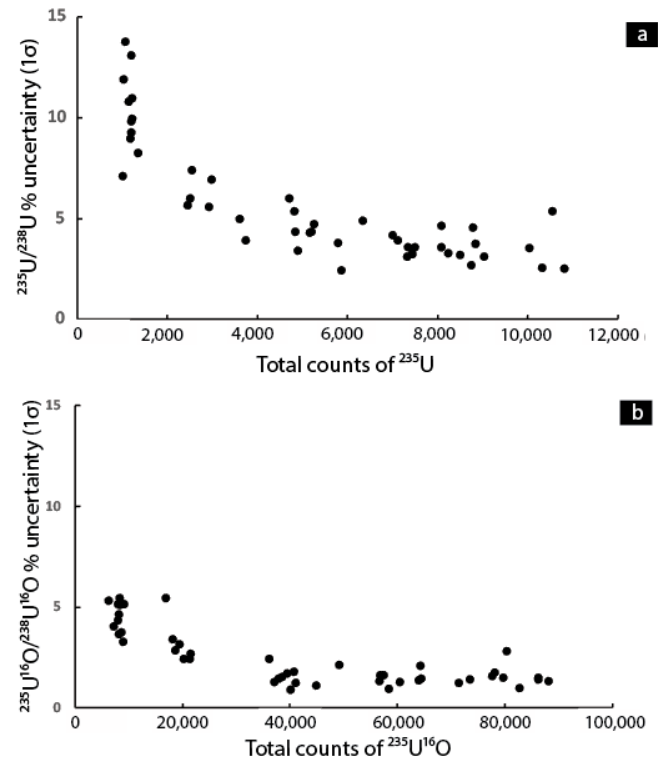
Figure 2. Plot of the percent uncertainty, calculated as 1 σ associated with the average of the ratios observed at each cycle of data during each analysis, on the ( a ) 235 U / 238 U and ( b ) 235 U 16 O / 238 U 16 O ratios as a function of the total number of counts of ( a ) 235 U and ( b ) 235 U 16 O observed during each analysis of the UO 2 sphere’s polished cross